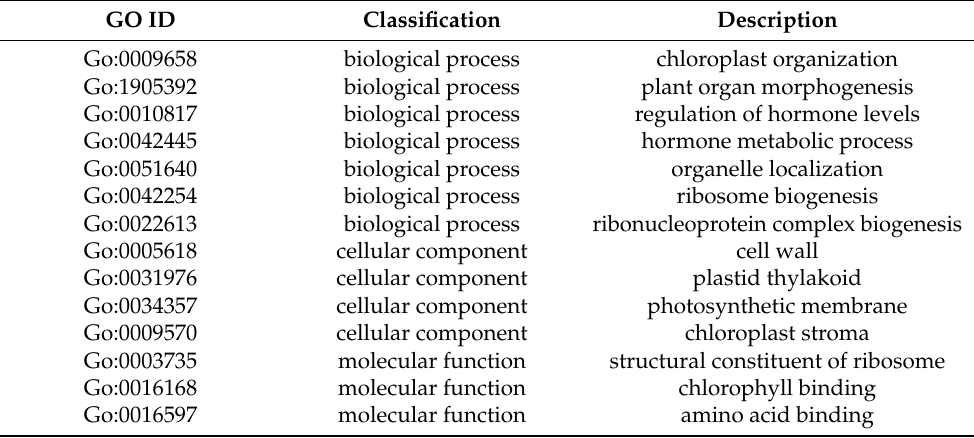
Table 1. GO enrichment analysis of DEGs in the contrasted melon lines during the stages of stigma development.